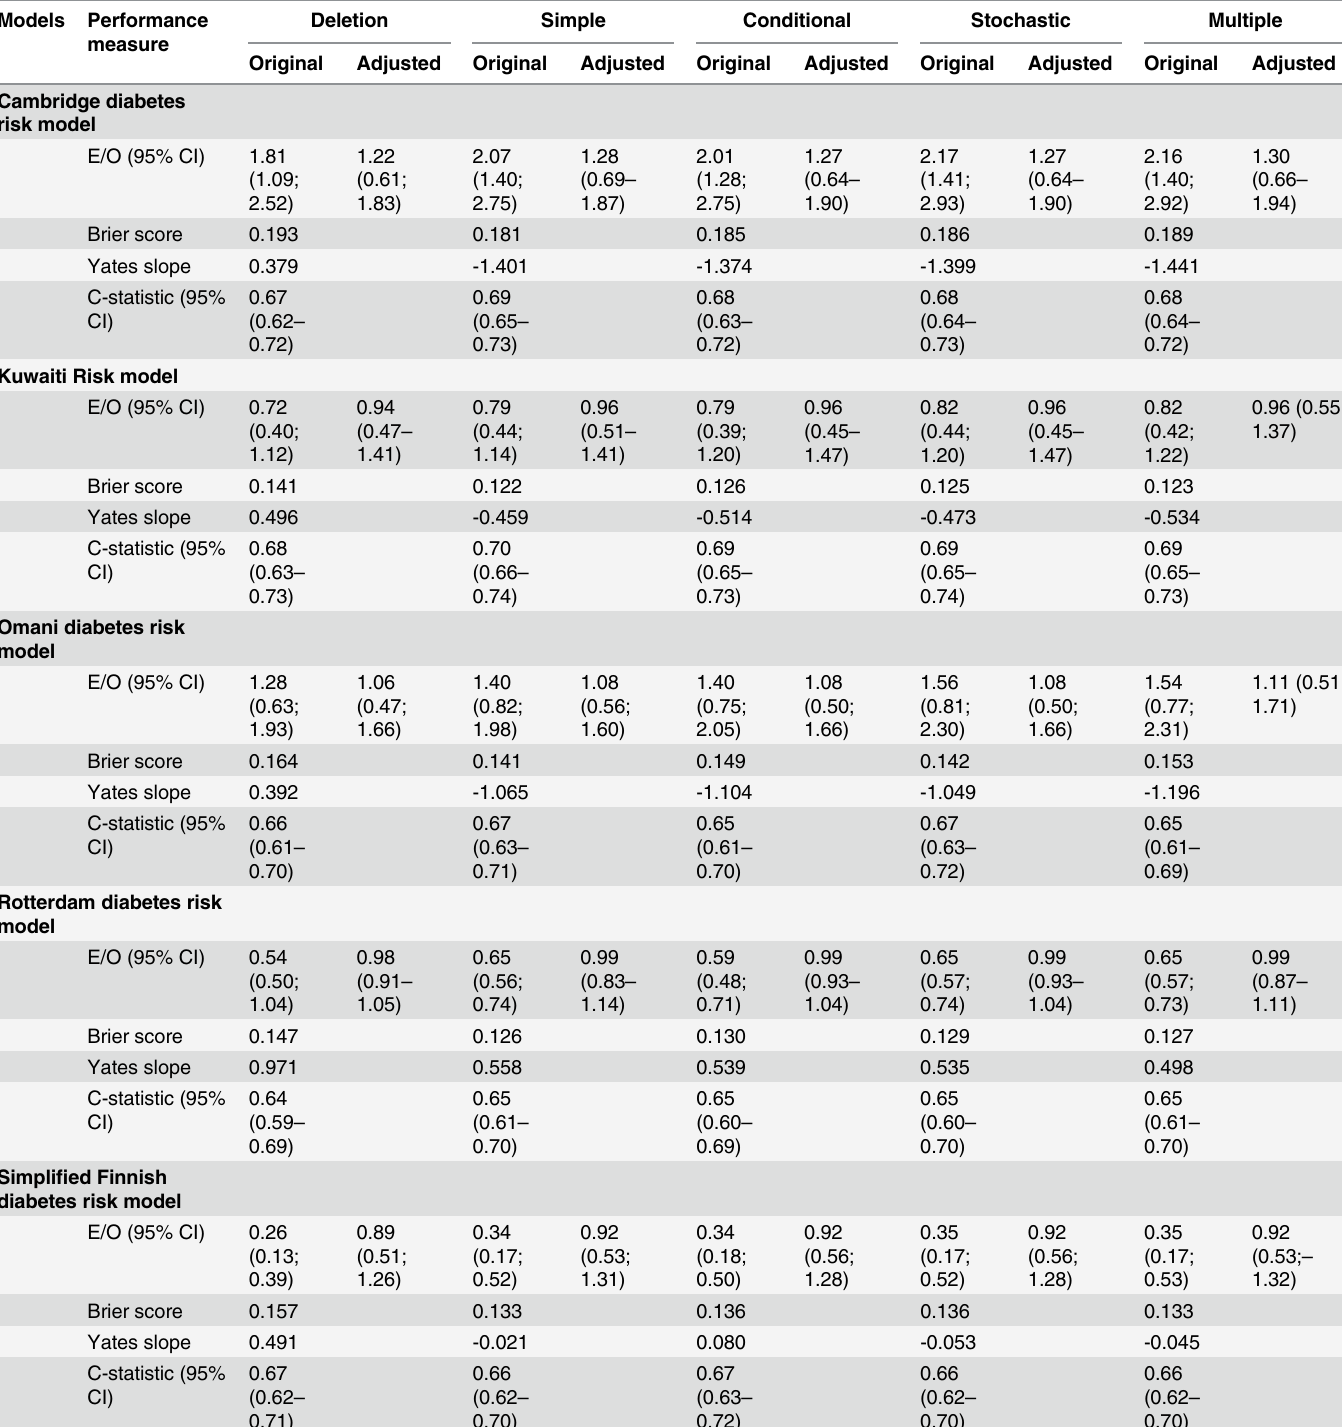
Table 1. Overview of the performance of the undiagnosed diabetes risk prediction models across the five imputation methods before (original) and after intercept adjustment